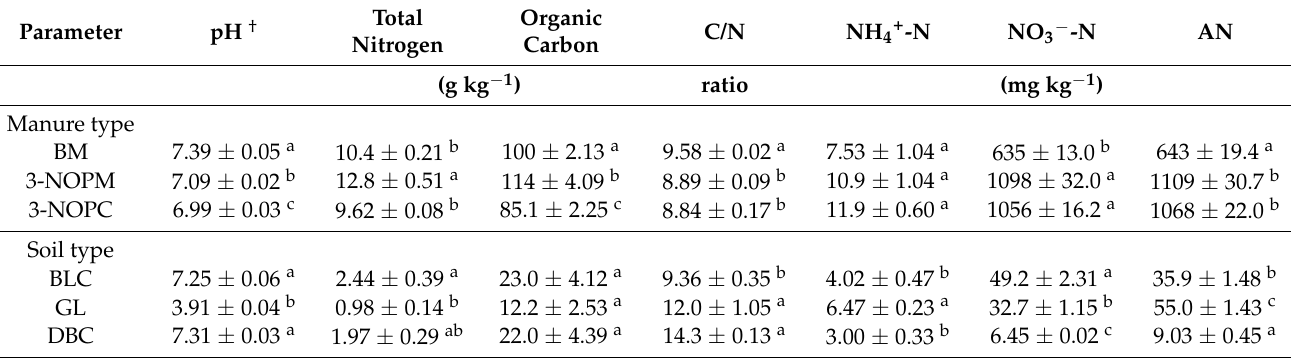
Table 1. Initial chemical properties (means ± SE) of soil and manure samples used in the laboratory incubation experiment ( n =